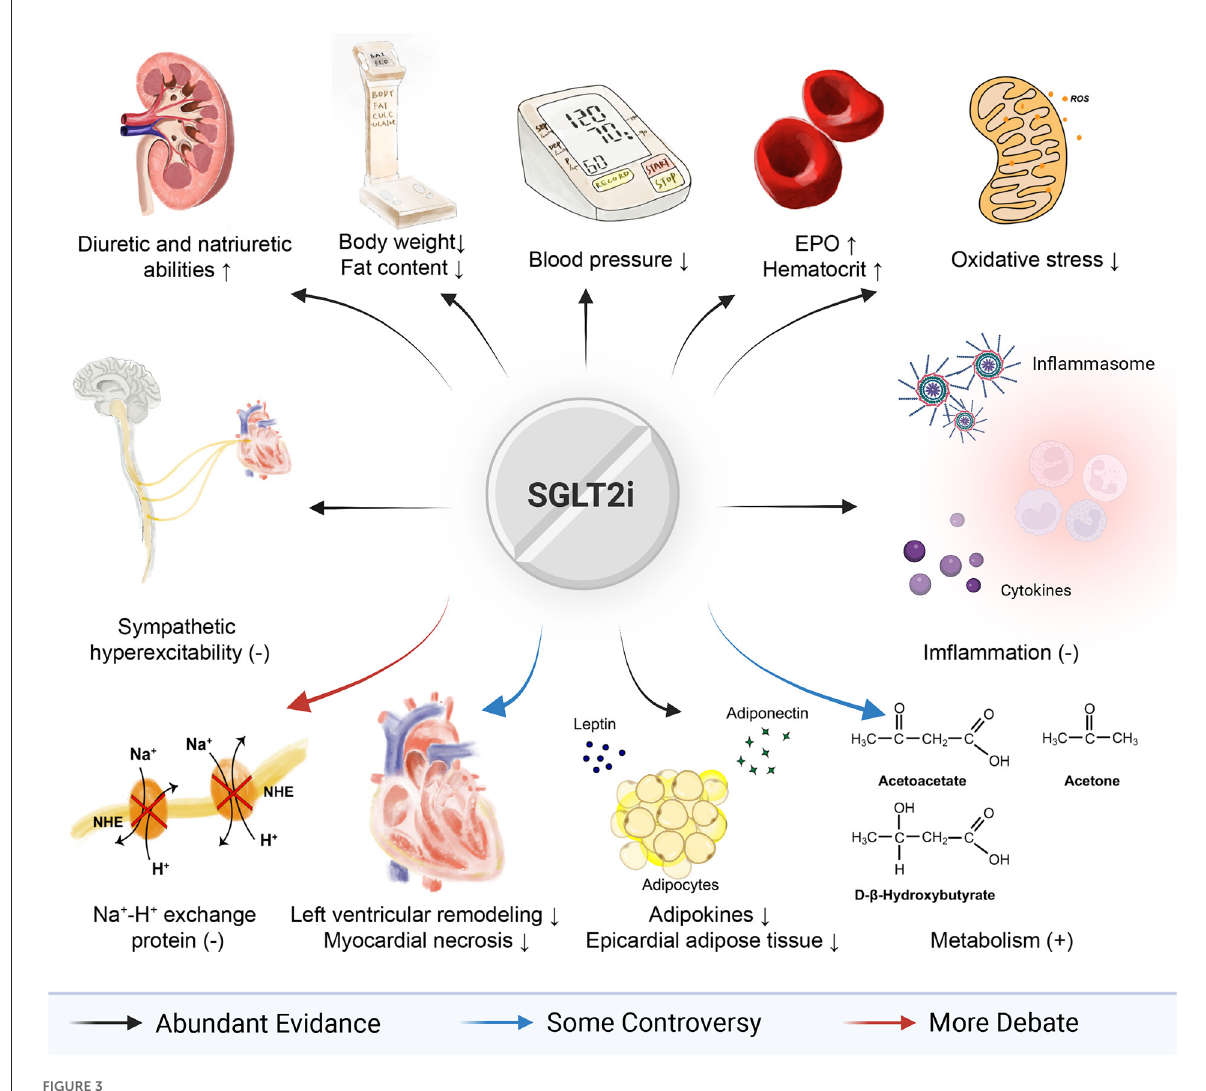
FIGURE3 Full view of SGLT2i in heart